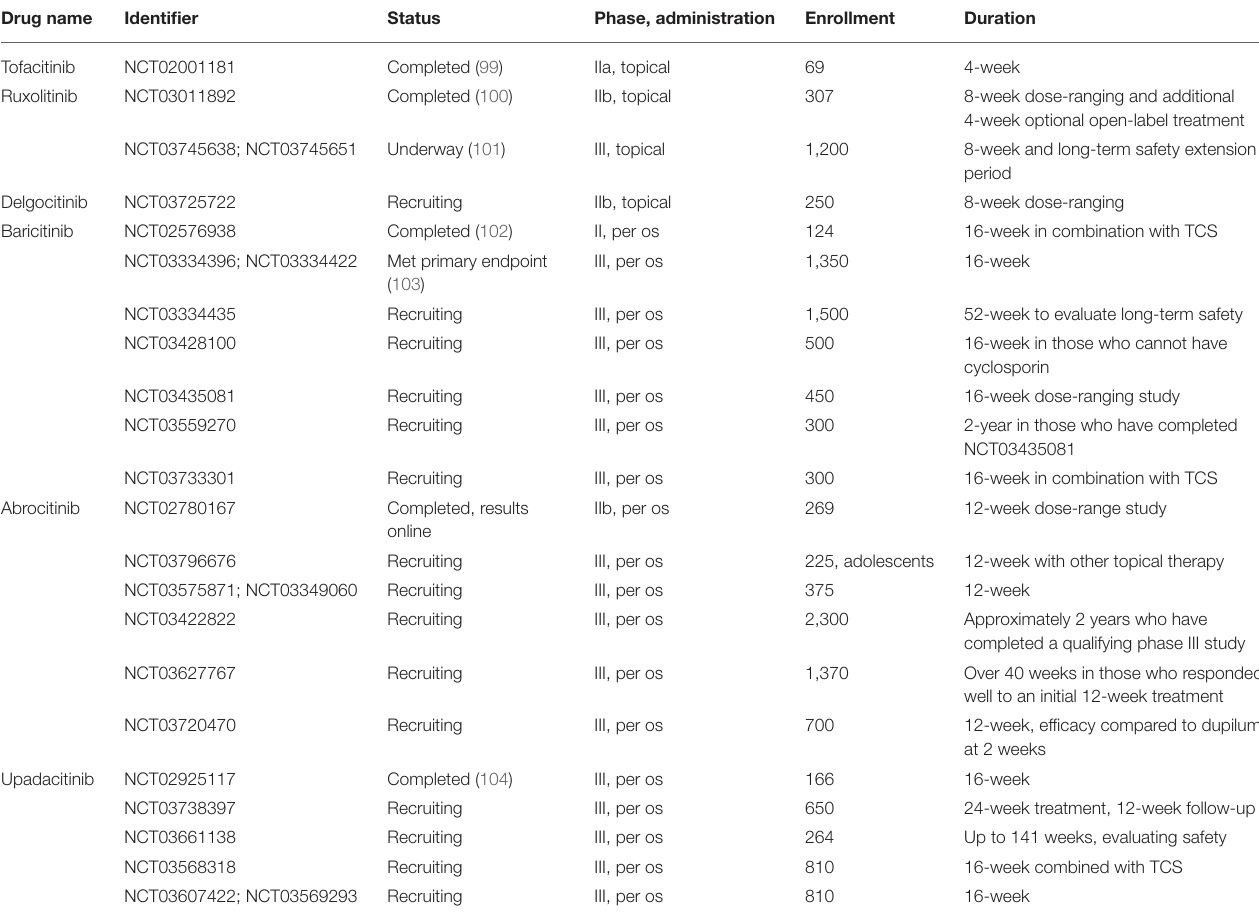
TABLE 3 | Phase II and III clinical trials studying Jak inhibitors in atopic dermatitis. Drug